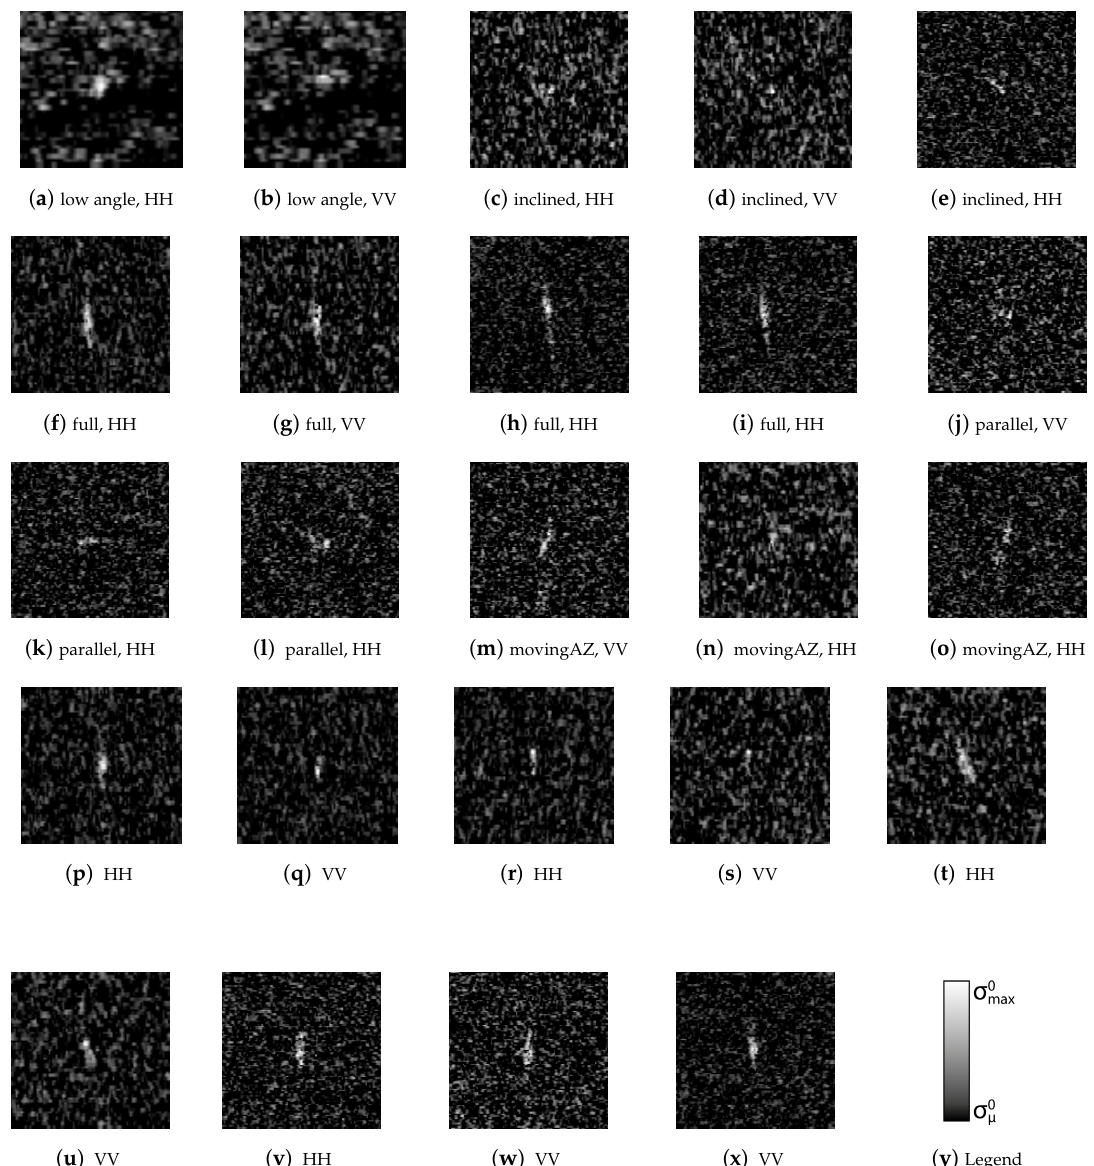
Figure 5. The vessel’s radar footprint in TSX-HS mode (©DLR, 2017) with indications for polarization and special scene or sensor